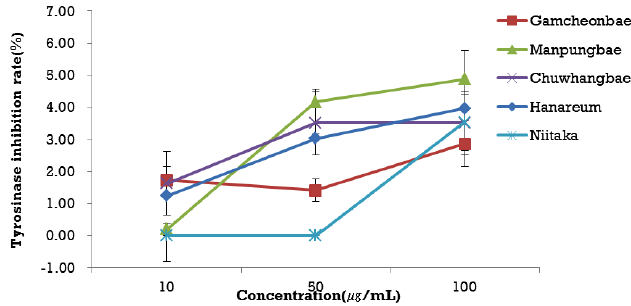
Fig. 1: The inhibition of mushroom tyrosinase in vitro among different pear cultivar extracts. Results are means + SD (n=3). The inhibitory effects of five pears cultivars on tyrosinase were measured at three concentrations: 10, 50, and 100 μg/mL.